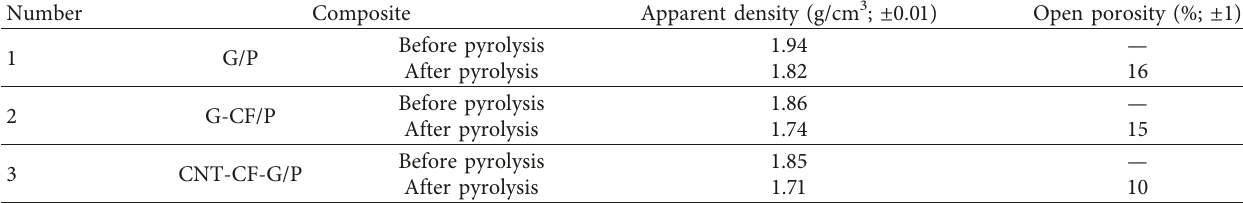
Table 3: Apparent density and open porosity values of composites before and after